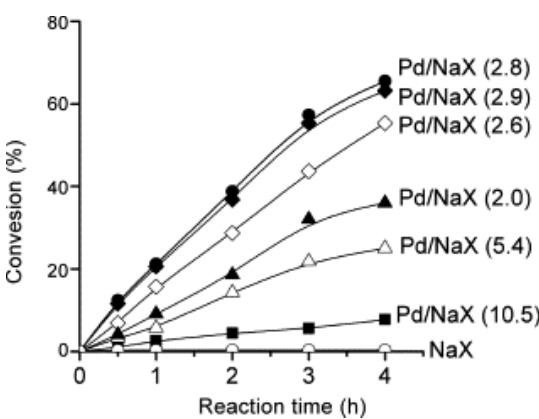
Figure 1. Conversions of benzyl alcohol versus reaction time over the 1.35 wt% Pd/NaX catalysts with different mean sizes of Pd particles. The mean size of Pd (in nm) was shown in the parenthesis. Reprinted from ref. [33]. Copyright 2008, with permission from Elsevier.